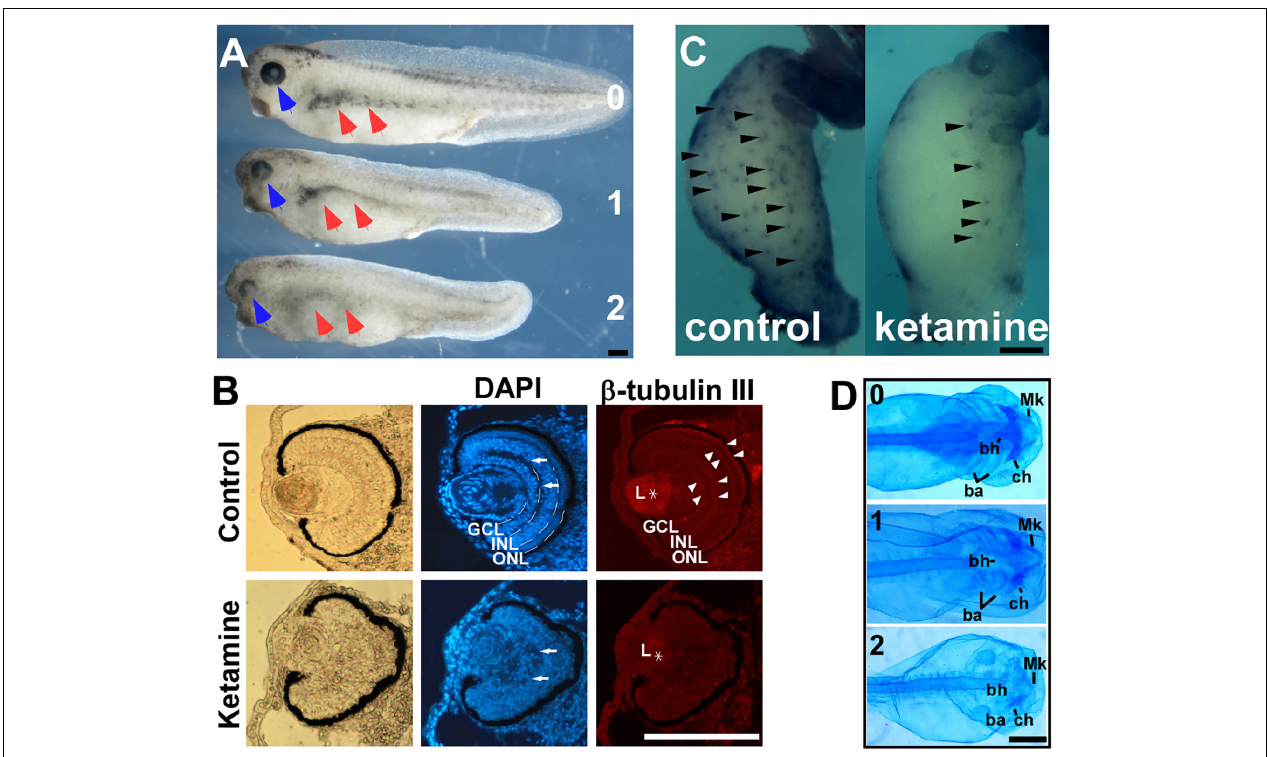
FIGURE 1 | Ketamine exposure results in neurocristopathies. Upon ketamine exposure from stage 7 to stage 13.5. (A) Embryos exhibit shortened axis, faded trunk pigment (red arrowhead), and deficient eyes (blue arrowhead) at tailbud stage and severity of phenotypes are in a dose-dependent manner. (B) Sections of eyes in ketamine-treated embryos revealed a more rounding shape pigment, disorganized arrangement of cells (DAPI staining), reduced expression of β -tubulin III compared with the control group. Ketamine exposure also causes embryos to develop a mega-colon like phenotype (C) , and cranial cartilage atrophy (D) . GCL, ganglionic cell layer; INL, inner nuclear layer; ONL, outer nuclear layer; L, lens; Mk, Meckel’s cartilage; ch, ceratohyal cartilage; bh, basihyal cartilage; ba, branchial cartilage. Numbers in (A,D) indicate ketamine exposure concentration (mM) to embryos. Scale bar: (A–C) 100 µ m, (D) 1